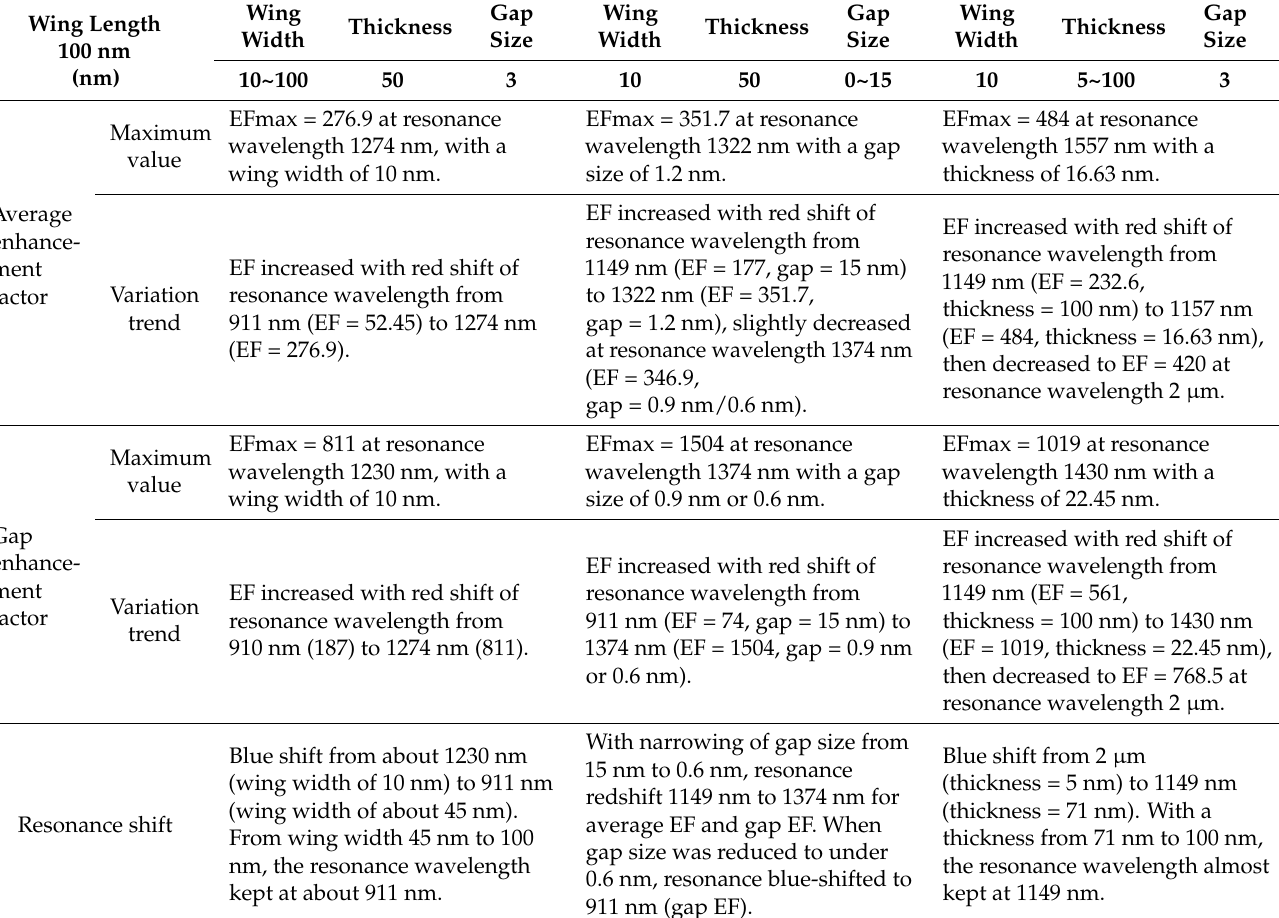
Table 2. Average enhancement factor, gap enhancement factor, and resonance shift depend on geometry of the PGNB on a sapphire